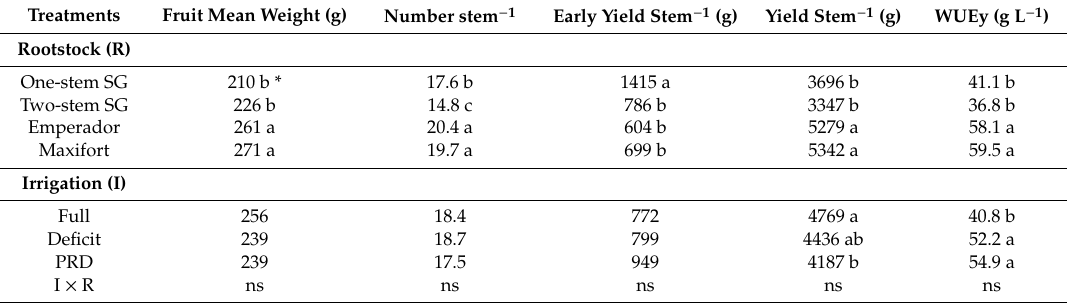
Table 5. Yield parameters and water-use e ffi ciency of grafted tomato plants grown with one and two stems under three irrigation techniques in the second year of the experiment.